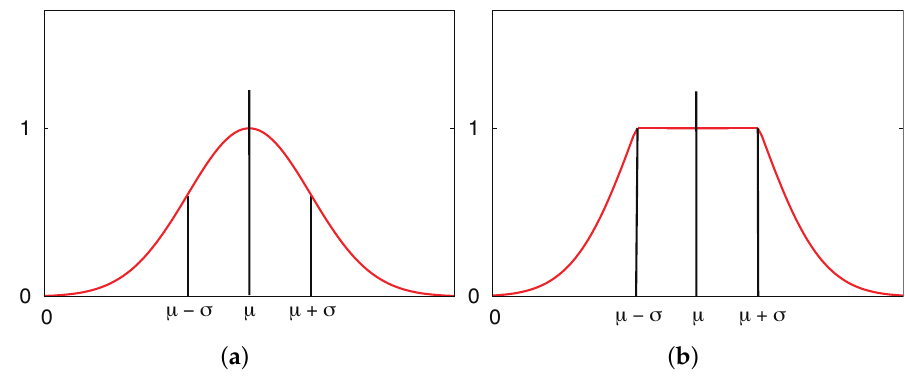
Figure 11. Likelihood functions for the measurement model of tag detection. ( a ) Gaussian model; ( b ) combination model.